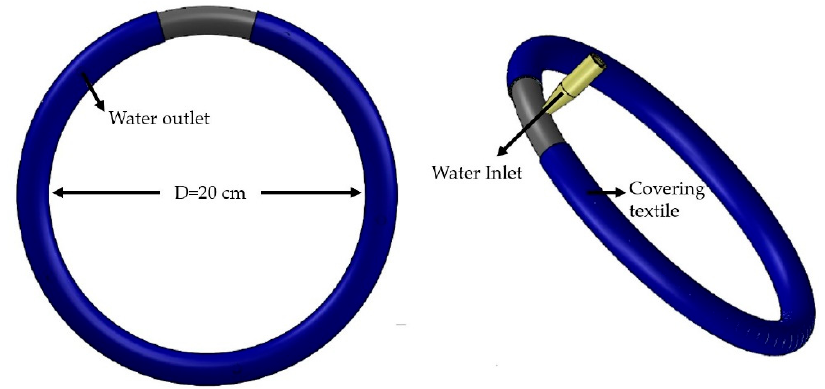
Figure 1. Configuration of the ring-shaped emitter (adapted from Saefuddin et al. [20]).